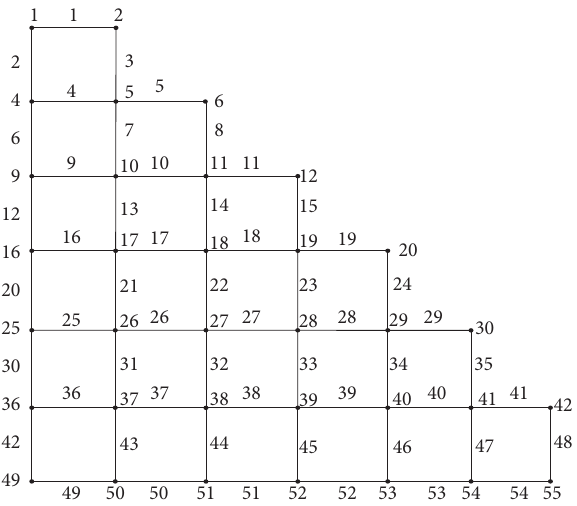
Figure 2: A classical mean labeling of ST